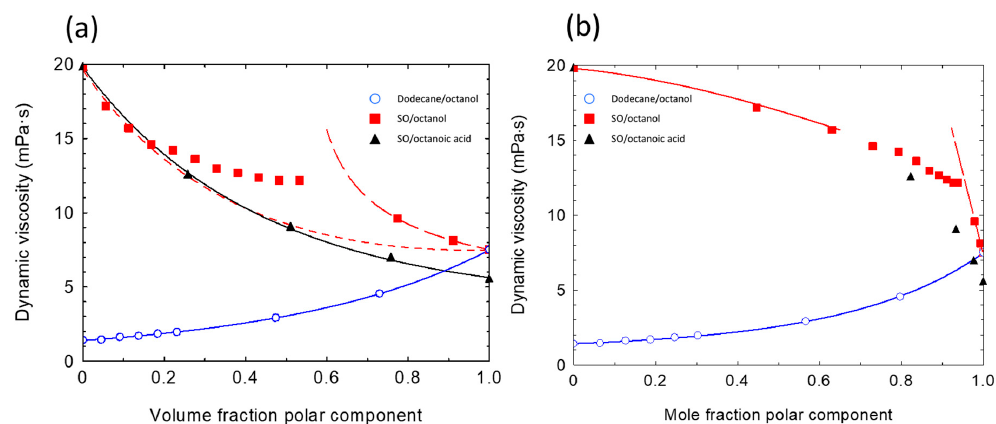
Figure 3. Dynamic (shear) viscosity plots for the binary mixtures. ( a ) Data plotted against volume fraction of polar component. The red long-dashed curve is derived using the Krieger–Dougherty equation (Equation (3)) as described in the text; solid blue and black curves are fitted using Equation (1), and the red short-dashed curve is fitted using Equation (1) based solely on the low concentration silicone oil (SO)/octanol data. ( b ) Data plotted as a function of mole fraction of the polar components, in which the blue solid curve is the best fit using Equation (2) for dodecane/octanol, and the red solid curve is the best fit to SO/octanol data in the range 0 ≤ x 1 ≤ 0.65. The red long-dashed line is from the Krieger–Dougherty equation, which is converted from ( a ).